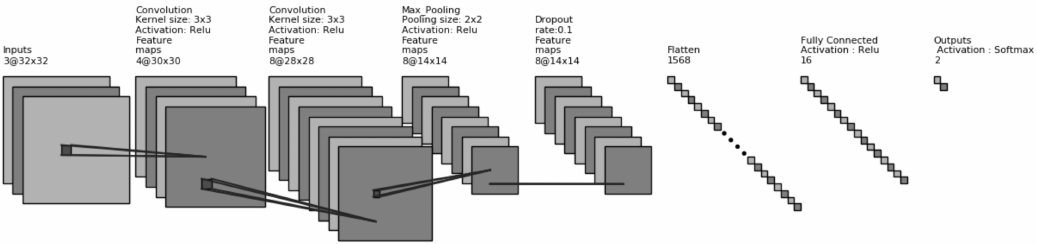
Figure 4. Custom 8 layers model architectures which is taken as a feature extractor for the general training procedure and knowledge distillation training